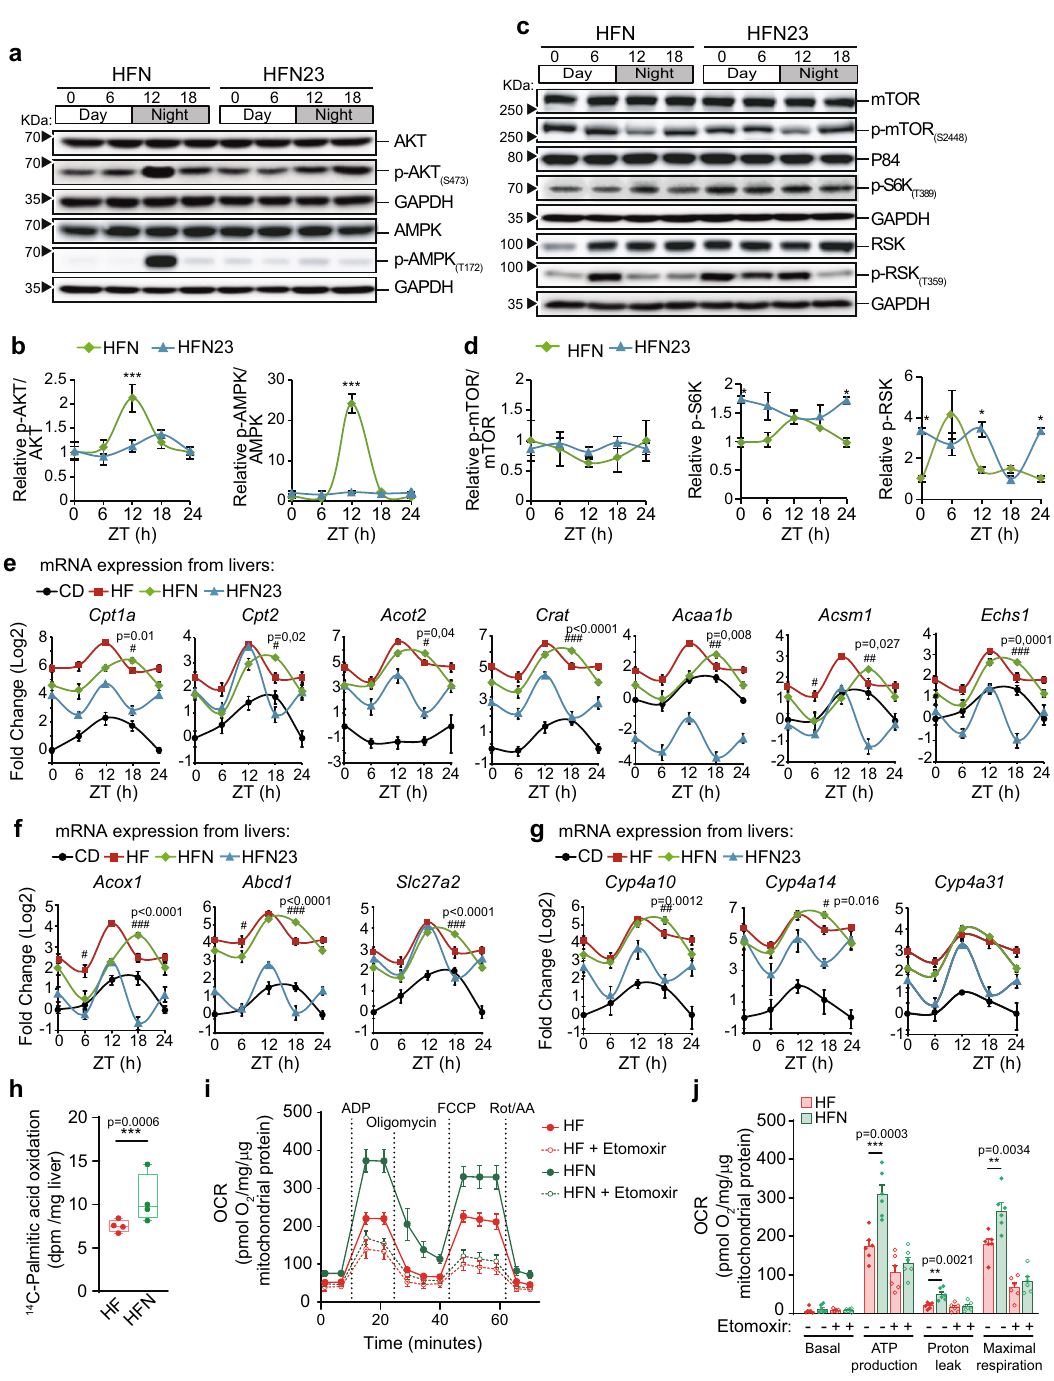
Fig. 6 | Distinct impact of NAD + treatment at ZT11 versus ZT23 on hepatic nutrient andinsulinsensingpathways.a ExpressionofAKT,p-AKT(S473), AMPK and p-AMPK(T172) along the day in the liver from micetreated with NAD + either at ZT11 (HFN) or at ZT23 (HFN23) determined by western blot. Uncropped blots in Source Data. b Quanti fi cation of western blots from n =5 biological samples, nor- malized to GAPDH loading control. Data from CD at ZT0 was set to 1. c Expression of proteins and phosphor-proteins in the mTOR pathwayalong the day in the liver frommicetreatedwith NAD + assessed bywesternblot. d Quanti fi cationof western blots from n =5 biological samples. Measurements were normalized to p84 or GAPDH loading controls. Data from CD at ZT0 was set to 1. e – g RT-qPCR deter- mined expression of rate-limiting and regulatory enzymes involved in mitochon- drial ( e ) or peroxisomal ( f ) β -oxidation, and ( g ) ω -oxidation ( n =5 mice for CD and HF, 6 for HFN and 5 for HFN23 except at ZT6, where n =6). h 14 C-palmitic acid oxidation was assessed by quantifying 14 CO 2 release ex vivo from livers of HF and